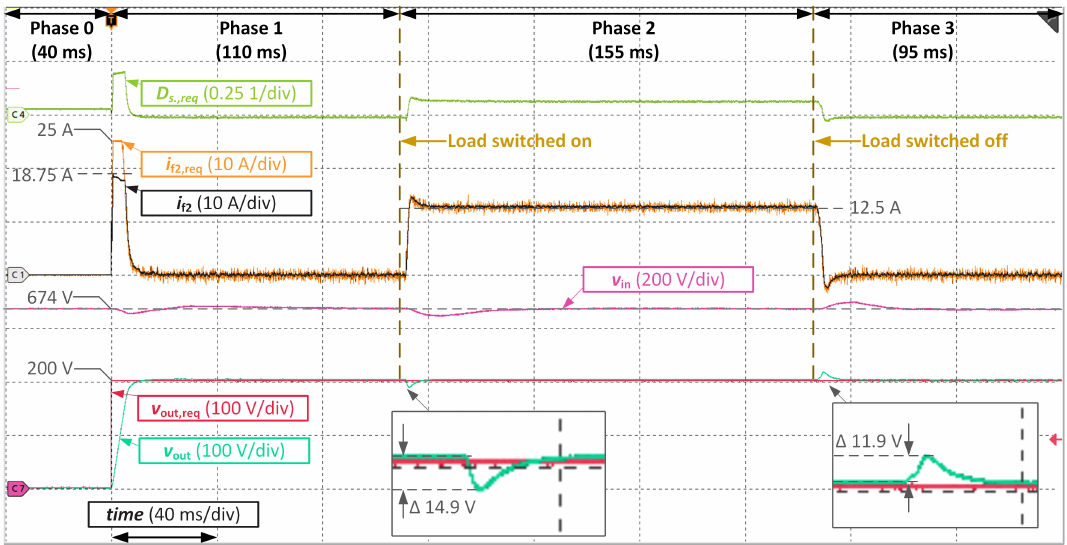
Figure 20. Experimental results for voltage controller tuned with reduced dynamics : reference voltage value for the active rectifier v in,ref = 670 V, reference output voltage value for the DAB converter v out,ref = 200 V, additional current limitation I spec = 25 A, resistive load R = 16 Ω